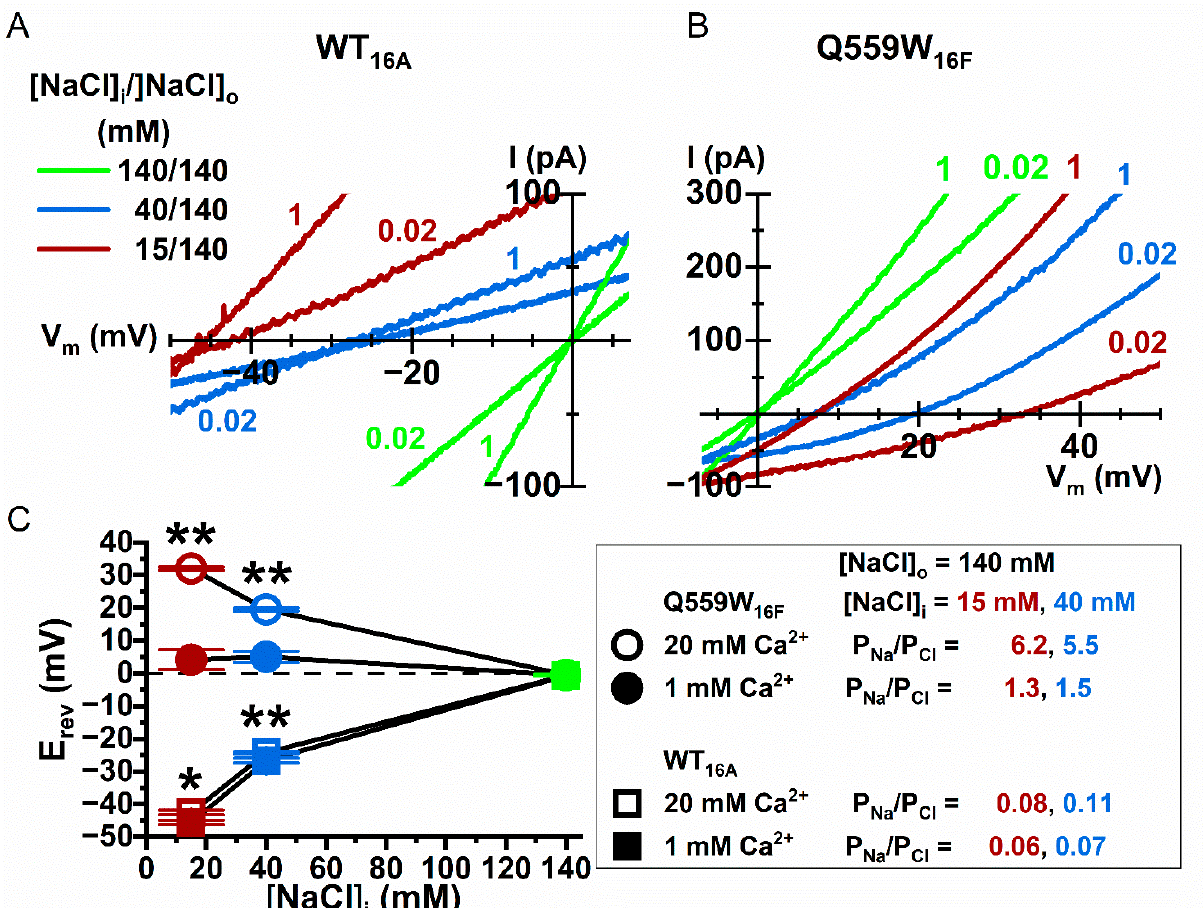
Figure 7. Intracellular Ca 2+ effect on the Na + versus Cl - permeability ratios (P Na /P Cl ) of TMEM16 currents. Representative I–V curves for ( A ) WT 16A and ( B ) Q559W 16F under asymmetrical [NaCl]. [NaCl] o = 140 mM in all recordings, whereas [NaCl] i was 140 mM (green), 40 mM (blue) and 15 mM (red), respectively. The reduced [NaCl] i in the 40 and 15 mM [NaCl] i solutions was replaced with D-mannitol. Currents were elicited with either 0.02 mM or 1 mM [Ca 2+ ] i , indicated by the colored numbers next to each curve. ( C ) Summary of reverse potential (E rev ) measured under asymmetrical [NaCl] for WT 16A (squares) and Q559W 16F (circles). The P Na /P Cl ratios (calculated based on the Goldman–Hodgkin–Katz equation, see equation 1 in Materials and Methods) of WT 16A and Q559W 16F are shown in the box on the right and in Table 1 ( n = 5–15). * p < 0.05; ** p < 0.005 by one-way ANOVA followed by Bonferroni’s multiple comparisons. Table 1. Calculated P Na / PCl of WT 16A and Q559W 16F.